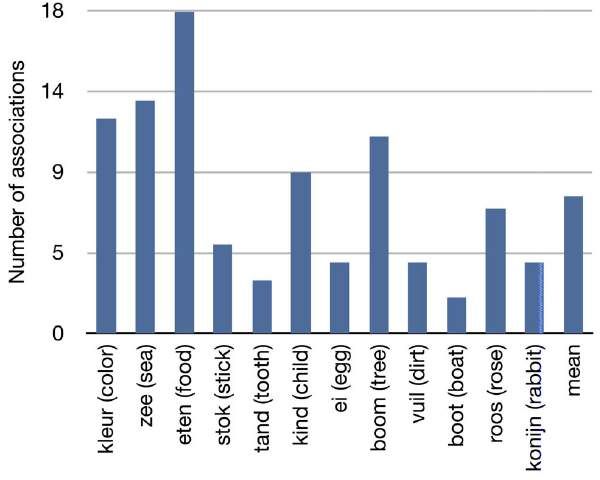
Figure 3. Association strength. Average association strength per block. The error bars indicate the standard deviation.